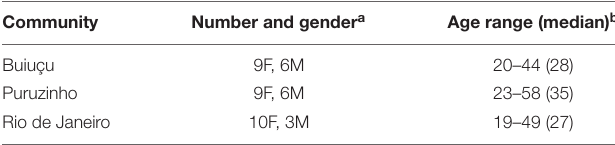
TABLE 1 | Characteristics of subjects from the three communities studied.